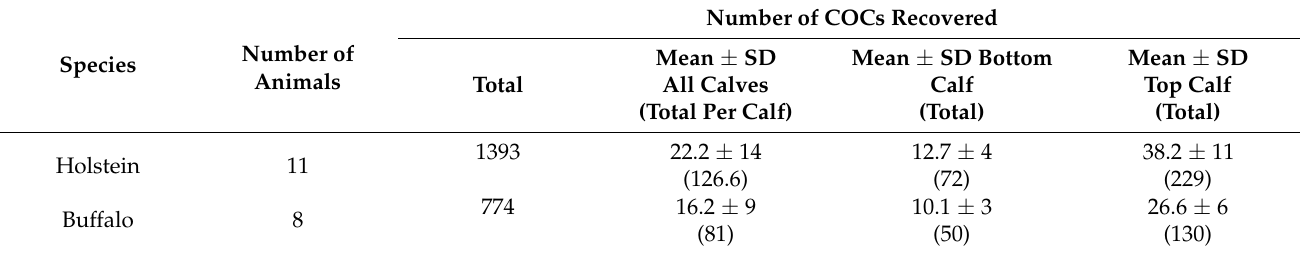
Table 1. Individual variation of usable COCs recovered from calves over six LOPU sessions.